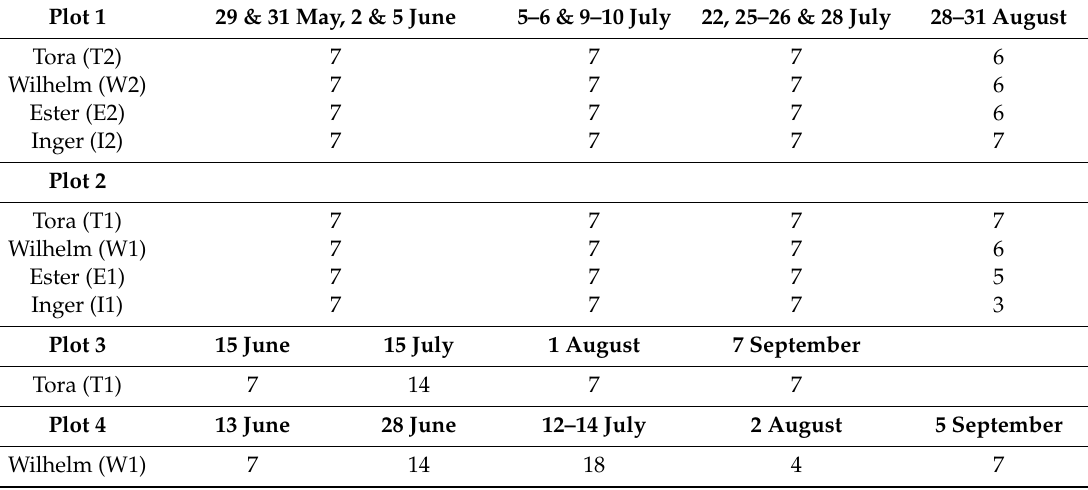
Table 2. All of the campaigns in 2017 and the number of samples taken for each variety. The abbreviations in the parentheses indicate what age the varieties were (e.g., T1 means the first growing season for